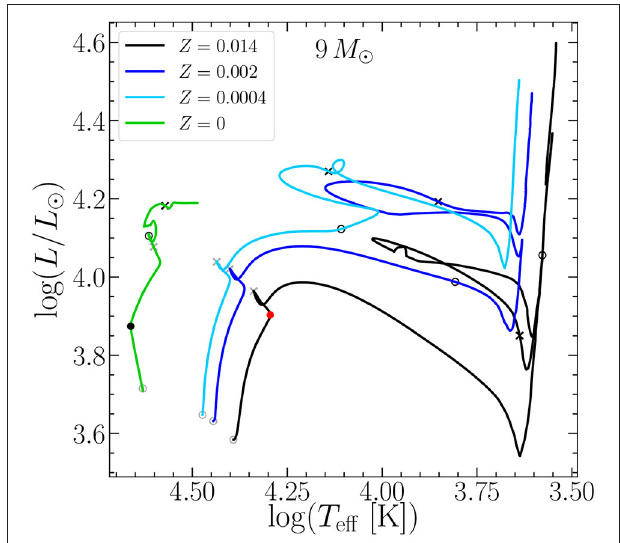
FIGURE 4 | HR diagram for 9 M models at different metallicities: Z 0.014 = ⊙ 0.002 (Georgy et al., 2013a), Z 0.0004 (Groh ( Ekström et al., 2012), Z = = et al., 2019), and Z 0 (Murphy et al., 2021). The beginning and end of fusion = phases are marked with a circle and a cross respectively (gray: H burning; black: He burning). The red dot on the black track marks the hook described in section 2.1. The filled black dot on the green track marks the point where the CNO cycle is ignited in the Z 0 model as described in section =